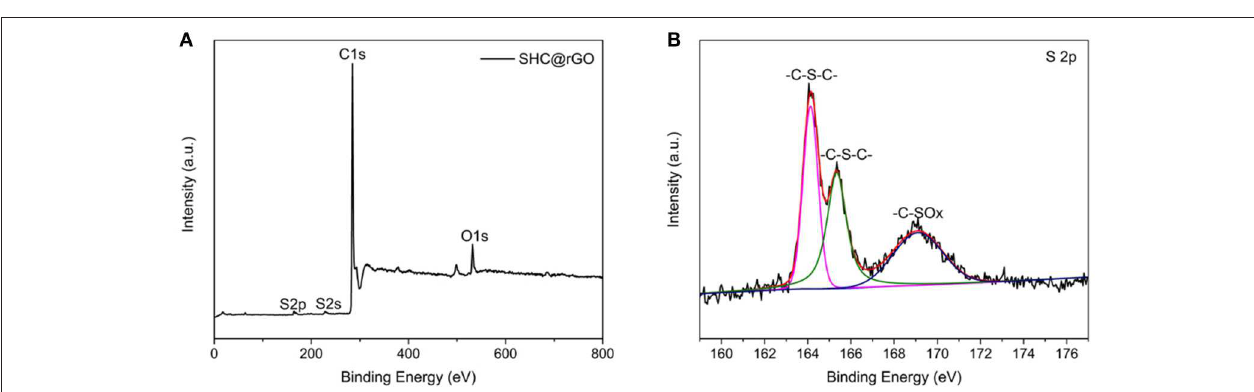
Figure 5D shows the TG/DSC curves for GO and